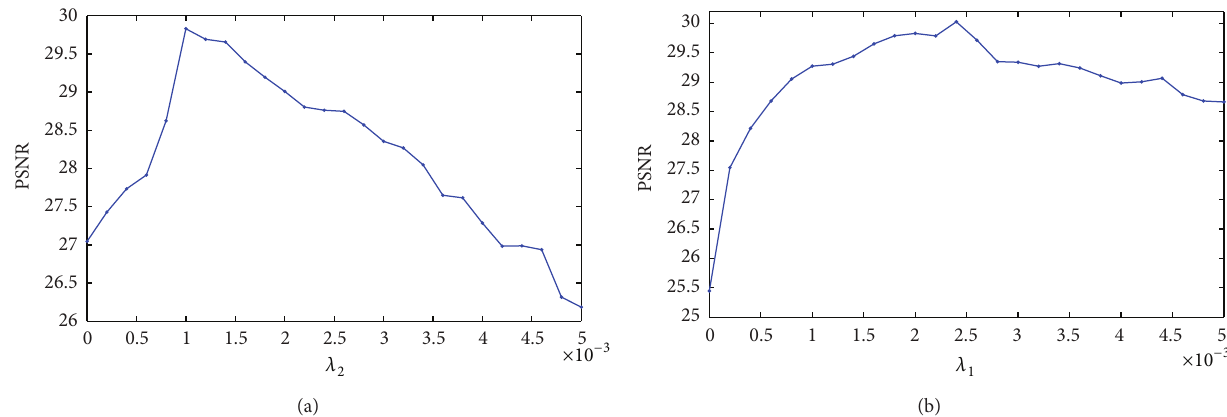
Figure 6: Analysis to find the optimum regularization parameters (for Coronal Brain data at sampling rate 0.25). (a) 𝜆 2 when 𝜆 1 = 0.002 for iCS method; (b) 𝜆 1 when 𝜆 2 = 0.001 for iCS method. Table 1: Optimal parameter selections at 0.25 sampling rate for coronal brain data and 0.2 for other data.